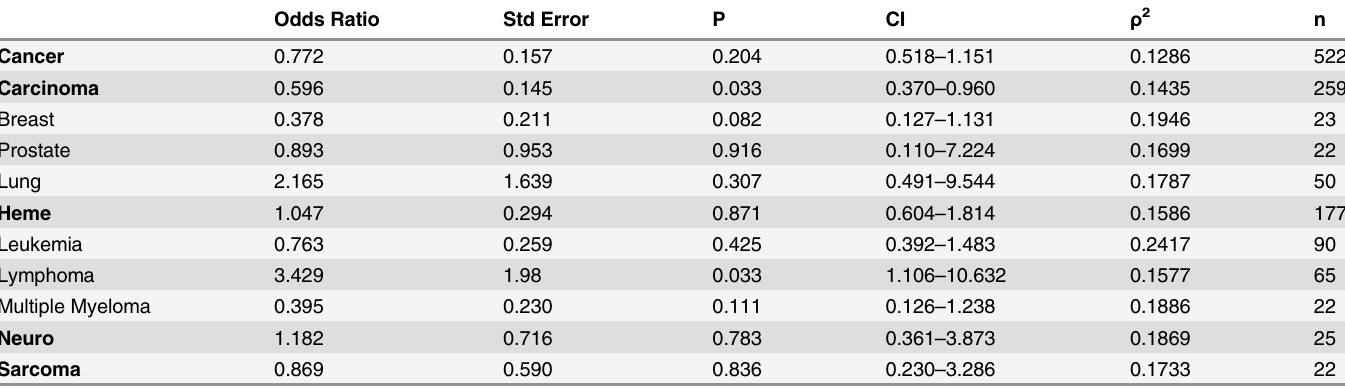
Table 3. Coronary atherosclerosis, statistical